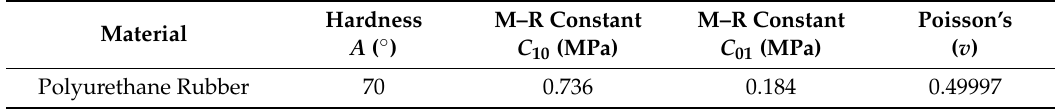
Table 3. Mechanical property parameters of polyurethane rubber material.